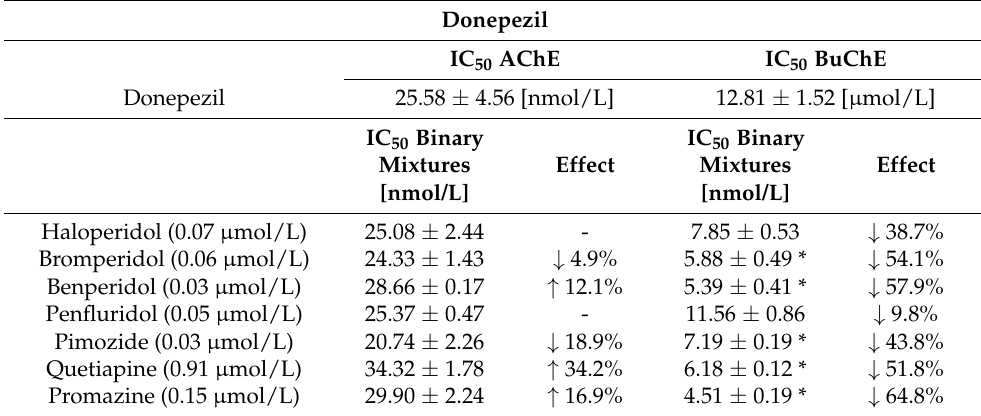
Table 3. Effects of antipsychotics on the anti-AChE and anti-BuChE properties of donepezil. Results are presented as mean ± SD, n = 6–9; * p < 0.05 vs. IC 50 of pure donepezil.